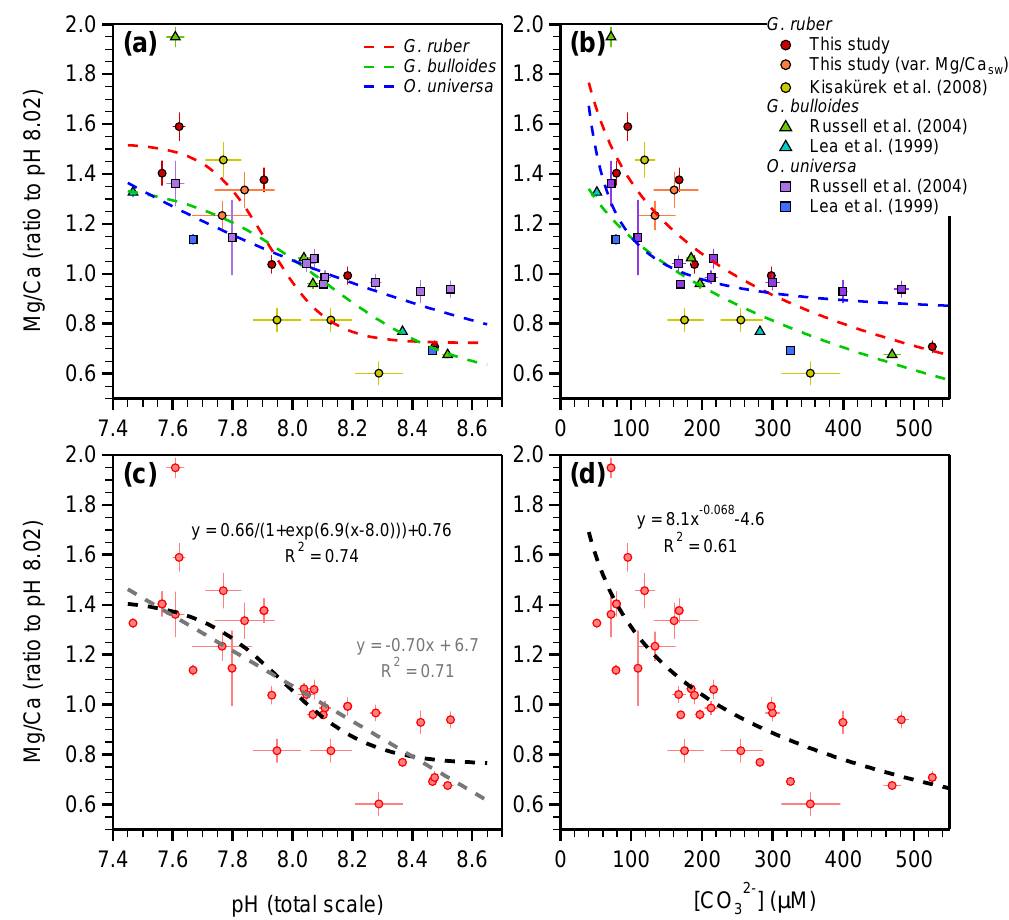
Figure 1. New and compiled planktic foraminifera Mg / Ca–carbonate-chemistry data. Mg / Ca is shown as a ratio to that at pH 8.02 ( ∼ 8 . 15 on the NBS scale) for each species. Panel (a) : species-specific Mg / Ca variation with pH. Panel (b) : Mg / Ca variation with [CO 2 − (c, d) show the same data sets with regressions calculated from all data combined. Both logistic and linear relationships are shown between Mg / Ca and